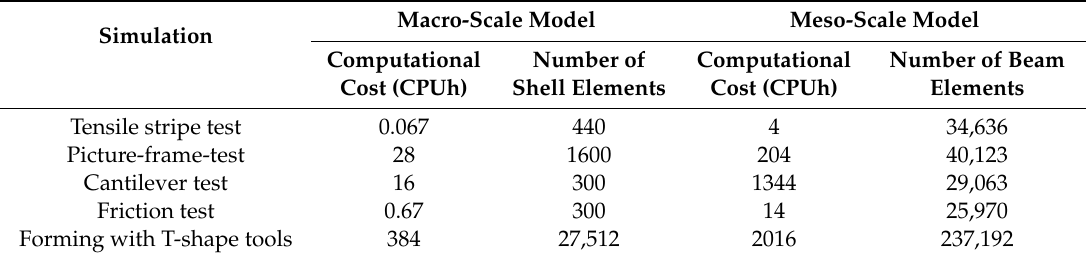
Table 4. Computational cost of both macro- and meso-scale models for textile variant 1.